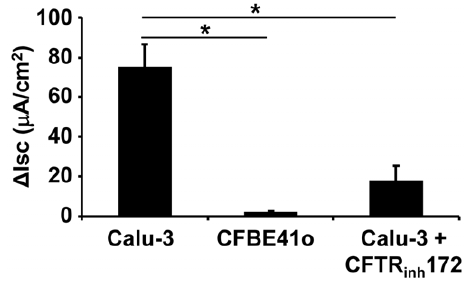
Figure 3. Adenosine-stimulated transepithelial I SC was medi- ated by CFTR channel. Calu-3 epithelia were stimulated with 100 m M of apical adenosine, resulting in a significant increase in I SC above baseline. Such an adenosine-induced I SC was mostly absent in CFBE41o cells in which CFTR channel was dysfunctional or was significantly inhibited with 25 m M of CFTR inhibitor CFTR inh 172. Student’s t-test was performed to determine the statistic significance ( p , 0.05, n=5).